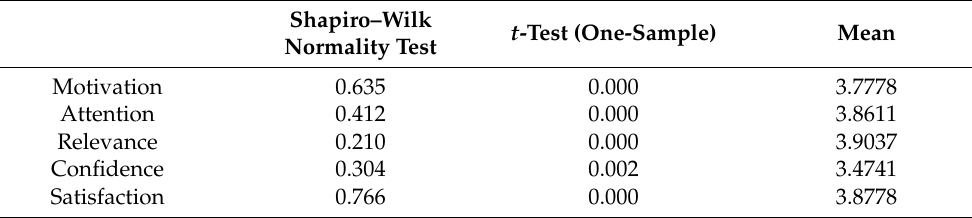
Table 3. Evaluation of students’ motivation, attention, relevance, confidence, and